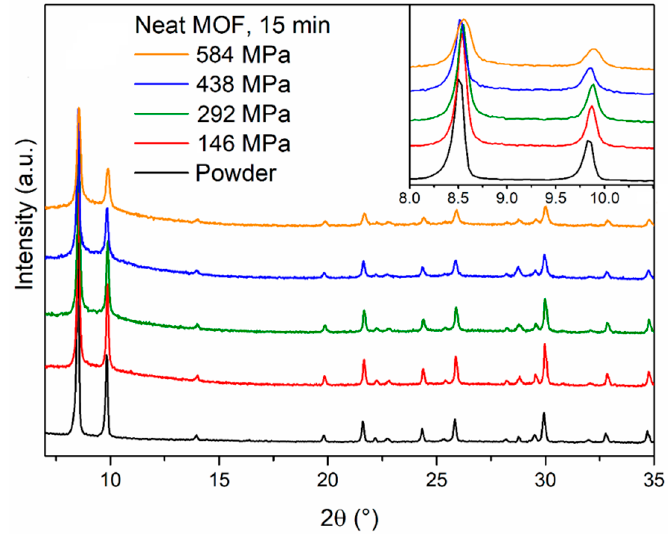
Figure 2. Powder X-ray diffraction (PXRD) patterns of MOF-801 powder (black) and pellets prepared compressing the same powder for 15 min under 146 (red), 292 (olive), 438 (blue) and 584 (orange) MPa pressure. The inset shows the low angle region.